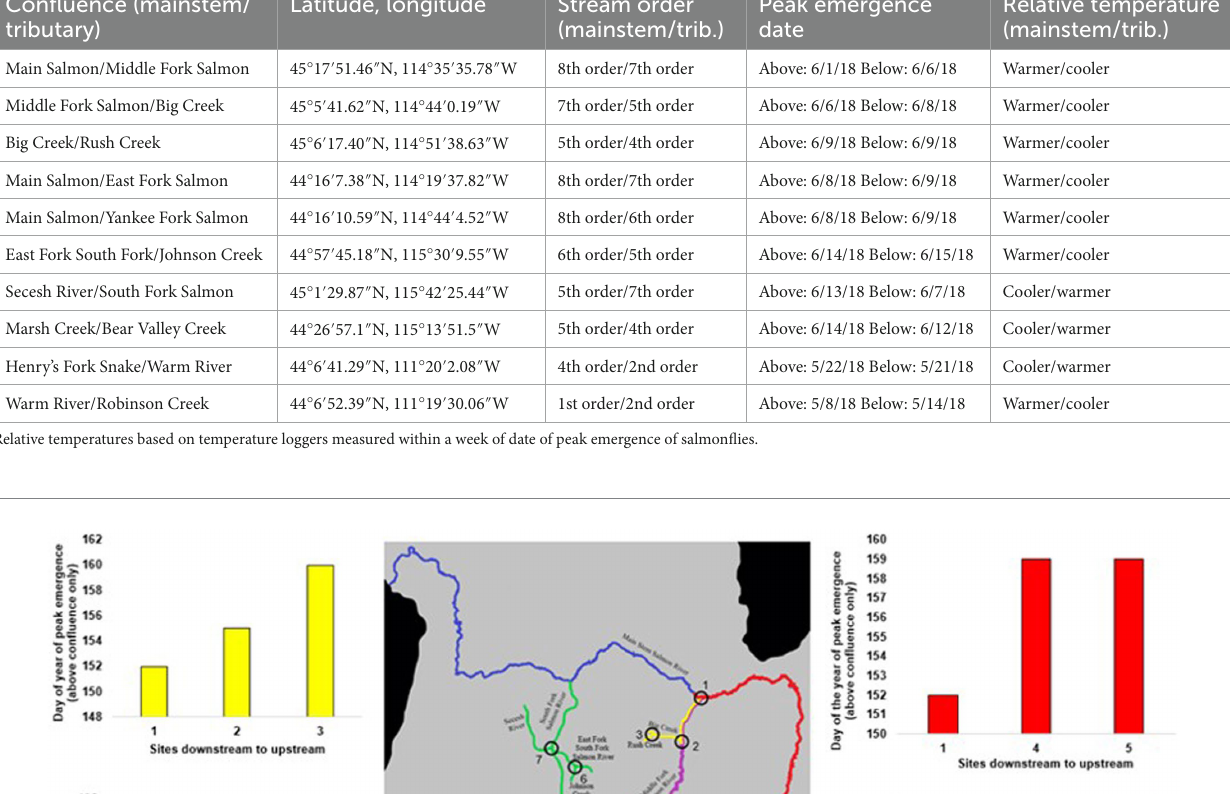
TABLE 2 Physical descriptions and locations for study sites in the Salmon River Basin and Henry’s Fork of the Snake River, Idaho, United States. Confluence (mainstem/